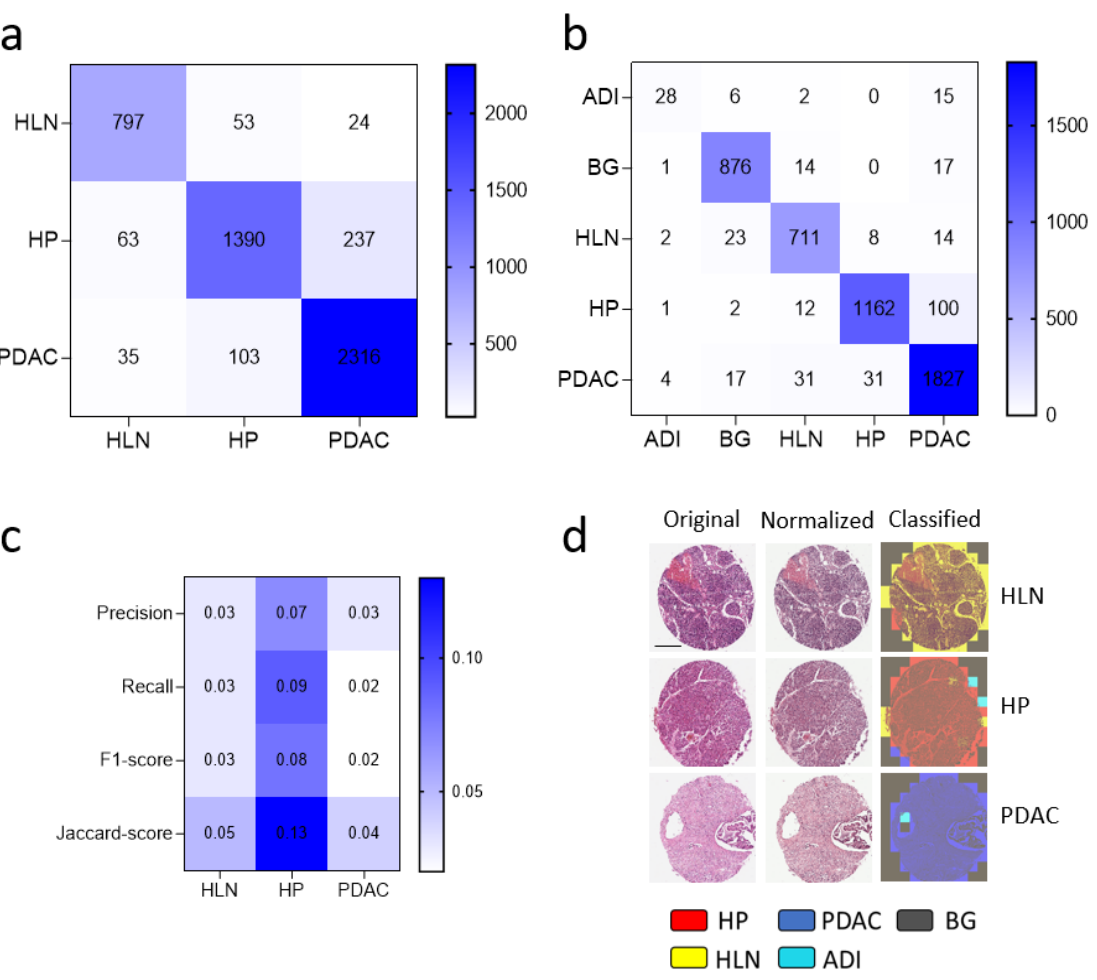
Figure 3. Data clean ‐ up using communicators improves network’s performance. Confusion Matrices from retraining the neural network with ( a ) original test data or ( b ) with data post ‐ clean ‐ up via communicators are shown. ( c ) Heatmap of the performance difference between the network trained on data with and without the data clean ‐ up via the communicators is shown. ( d ) Representative test spots from healthy lymph nodes (HLN), healthy pancreases (HP) and pancreatic ductal adenocarcinoma (PDAC) classified with the neural network are shown (scalebar = 300 μ m). HLN (yellow), HP (red), PDAC (blue), background (BG, grey) and adipose tissue (ADI, cyan) were predicted by the retrained CNN.